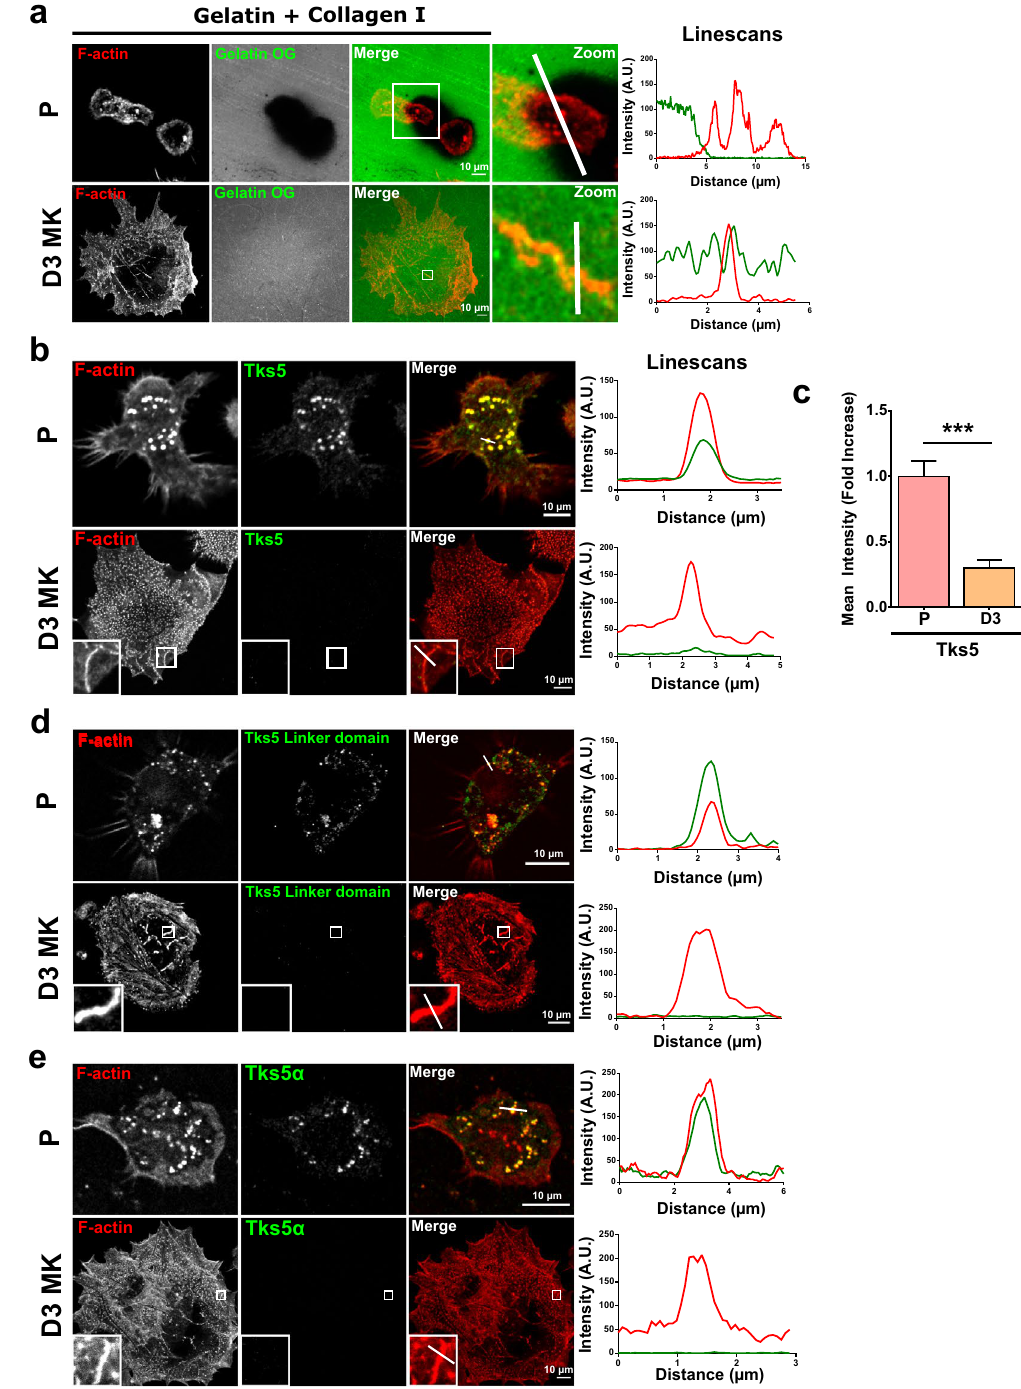
Figure 4. MKs lose their digestive ability together with Tks5 expression during maturation. ( a ) Lin − progenitors (P) and D3MKs were cultured for 6 h on gelatin- Oregon Green 488 (green) containing 100 µg/ml Horm collagen (non labelled) matrix prior to fixation and staining for F-actin (in red). ( b ) P and D3MKs were treated as in ( a ), then stained for F-actin (red) and Tks5 (green). ( c ) Quantification of mean Tks5 intensity per podosome from 3800 podosomes from 18 cells. Values are mean ± s.e.m.***P < 0.001 according to unpaired t-test. ( d ) P and D3MKs were treated as above, then stained for F-actin (red) and Tks5 linker domain (2G6 antibody) or ( e ) Tks5 PX domain (F4 antibody). Linescans show the distribution of fluorescence along the white line. Scale bars = 10 µm. n = number of cells